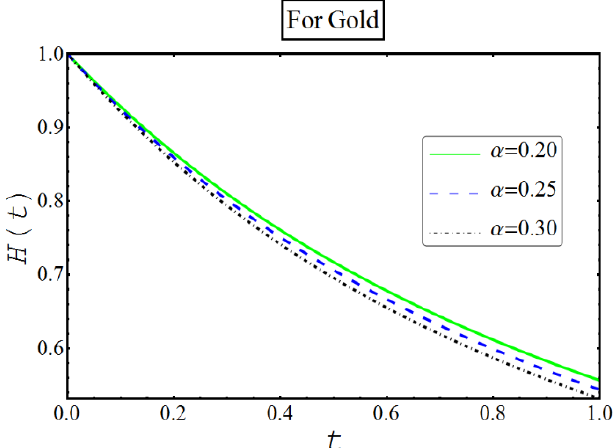
Figure 3. Behaviour of film thickness for different base fluids containing silver particles